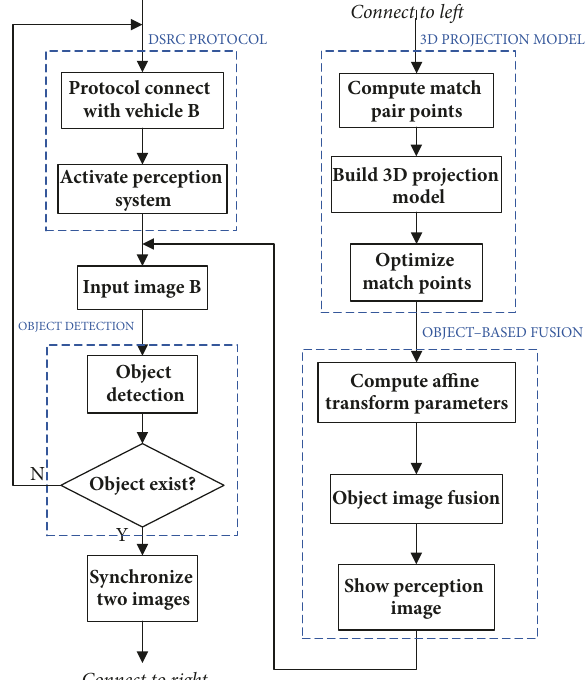
Figure 2: Flowchart describing the processing procedure of the perception